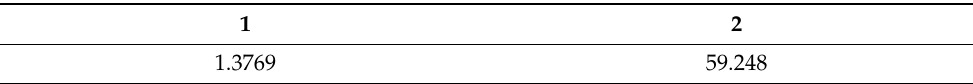
Table 9. Expected duration of each